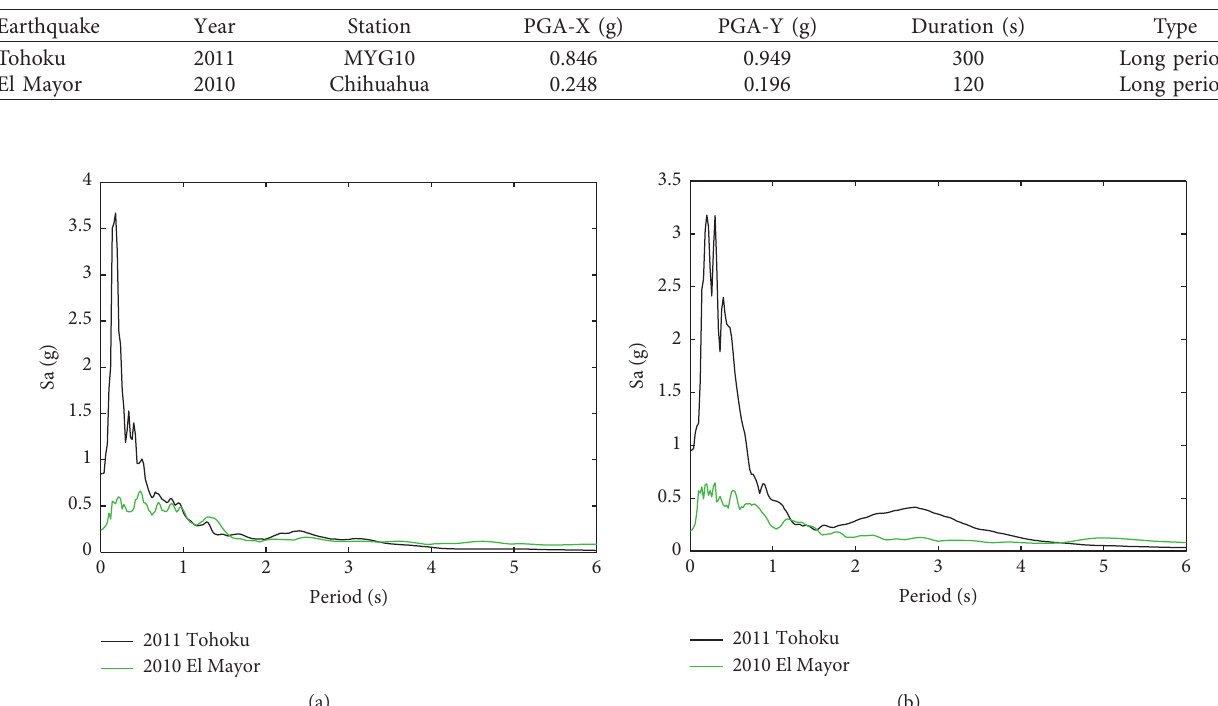
Table 4: Ground motion characteristics.